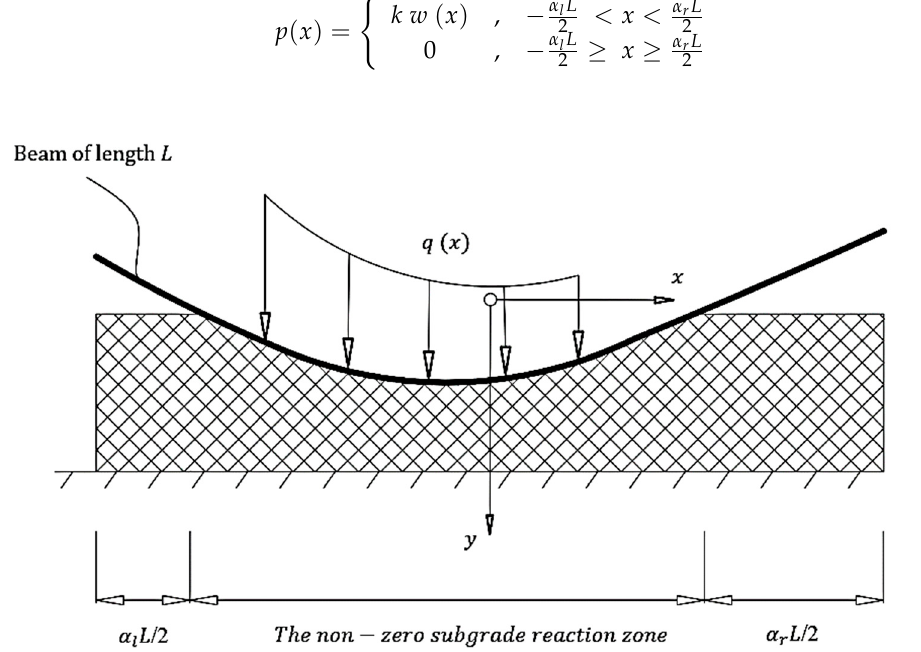
Figure 3. A simplified diagram of a free–free beam resting on tensionless foundation.